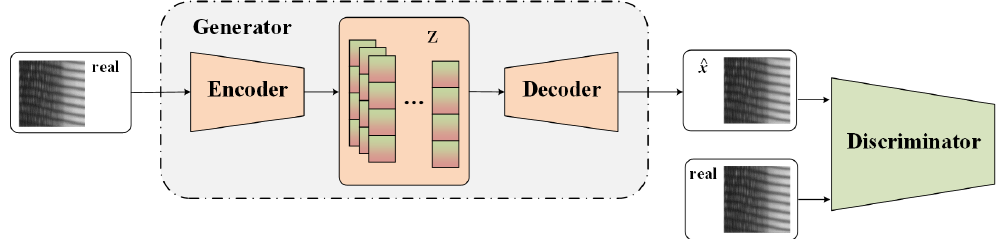
Figure 4. Structure of basic reconstruction GAN.